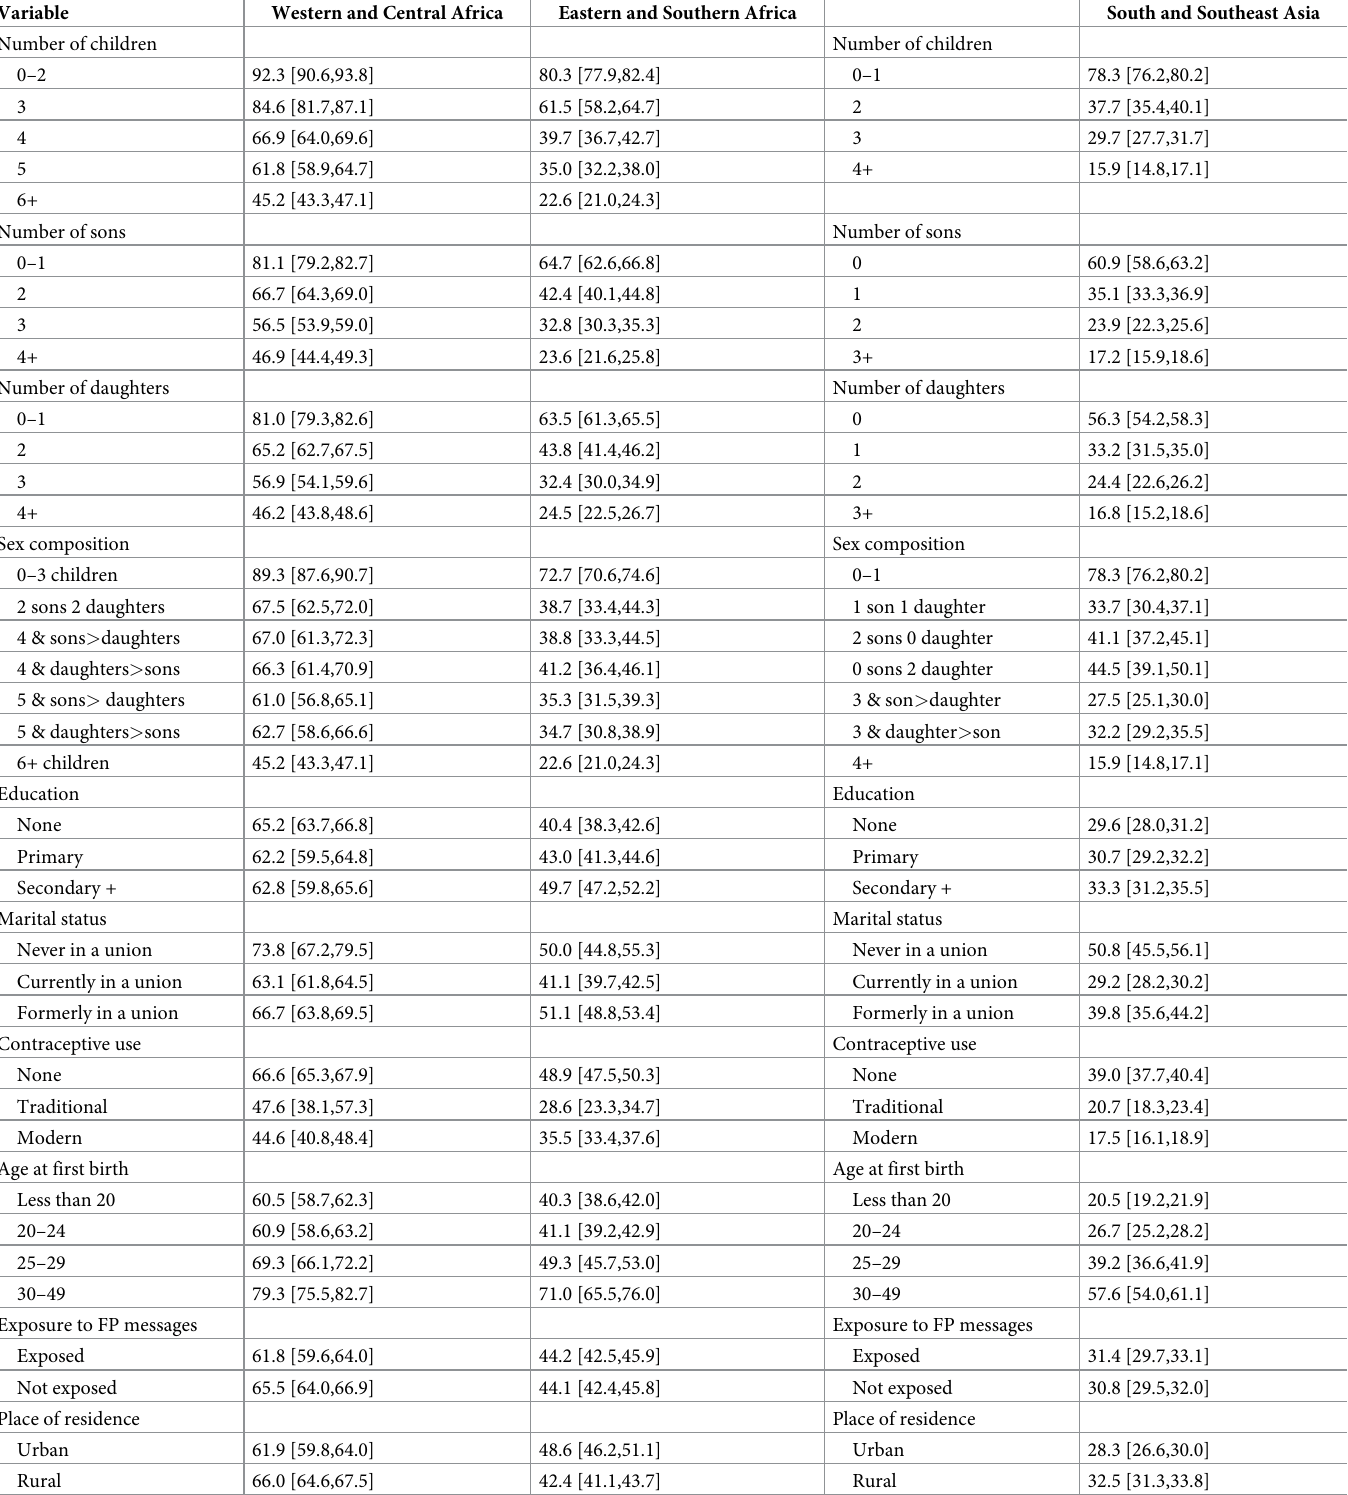
Table 3. Crosstabulation of unrealized fertility with background variables for each